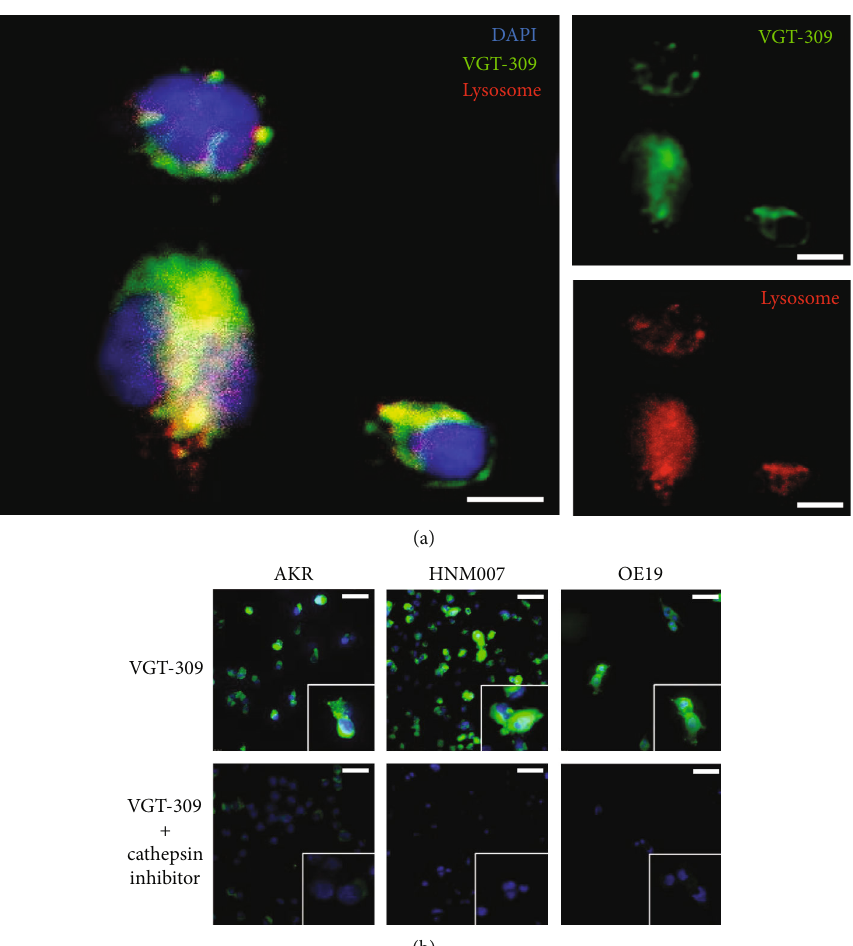
Figure 3: VGT-309 labels esophageal cancer cell lines in a cathepsin activity-dependent manner. (a). Fluorescence microscopy of OE19 (human esophageal adenocarcinoma) cells at 100 × magni fi cation 1 hour after treatment with 1 μ M VGT-309. Cells were costained with DAPI and LysoTracker. VGT-309 labeling (shown in green) is predominantly lysosomal (shown in red) in distribution. Overlay images are shown at left with VGT-309 channel and LysoTracker channels shown at right. Scale bars represent 5 μ m. (b). Fluorescence microscopy at 10 × and 40 × (inset images) showing VGT-309 fl uorescence in esophageal cancer cells with and without pretreatment